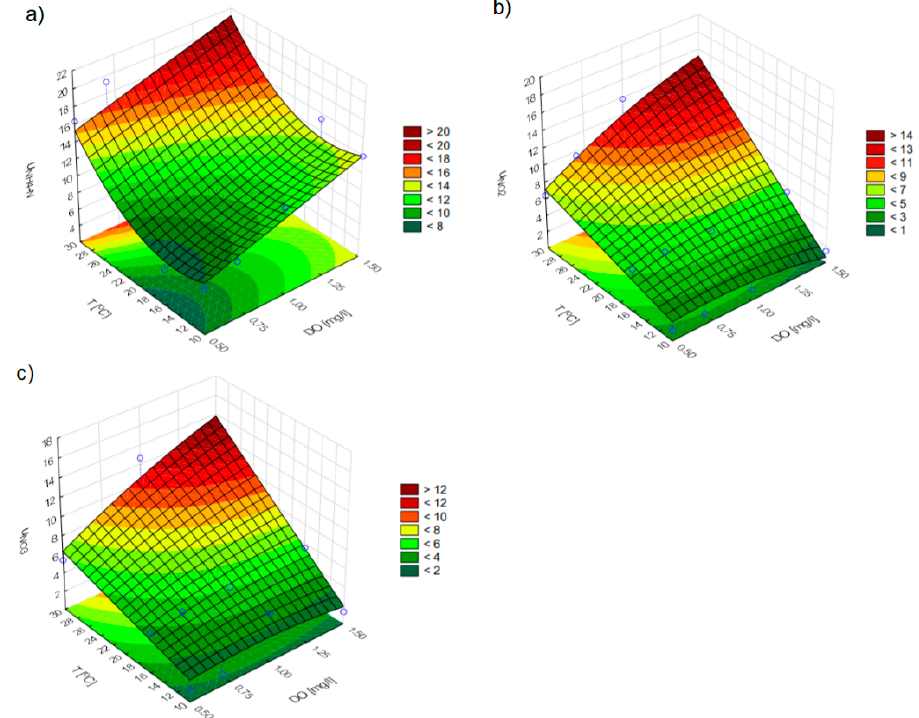
Figure 4. Influence of T and DO on the values: ( a ) μ NH4-N , ( b ) μ NO2-N , ( c ) μ NO3-N .